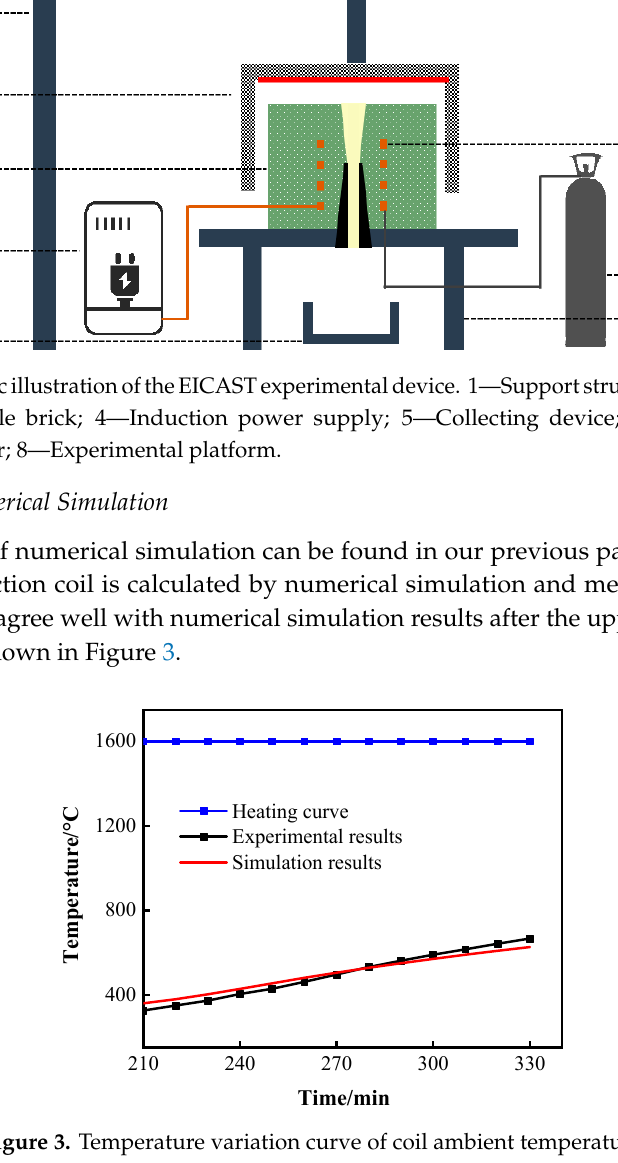
Figure 3. Temperature variation curve of coil ambient temperature.